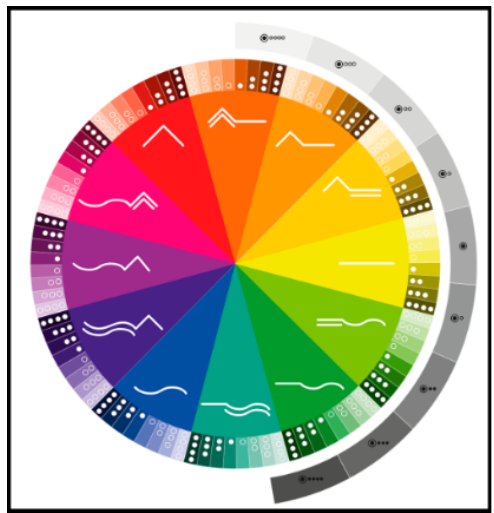
Figure 5. Constanz system. Source: http://www.sistemaconstanz.com/sistema-constanz/(2020)